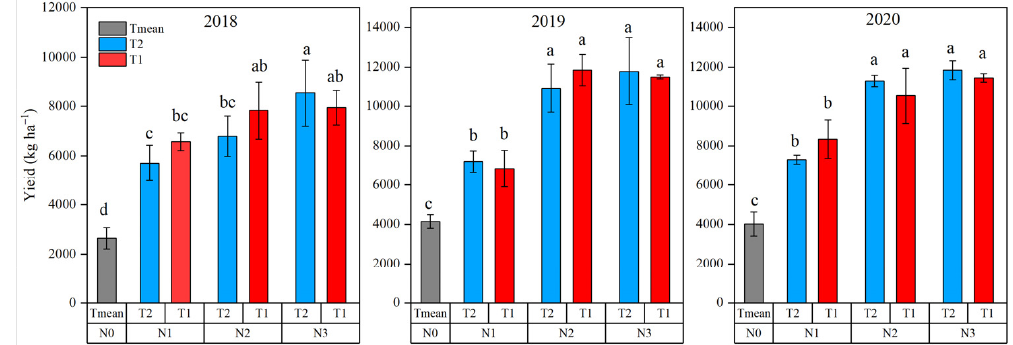
Figure 7. Grain yield of maize in 2018, 2019, and 2020, as affected by N supply. Different letters indicate significant differ- ences at p < 0.05.